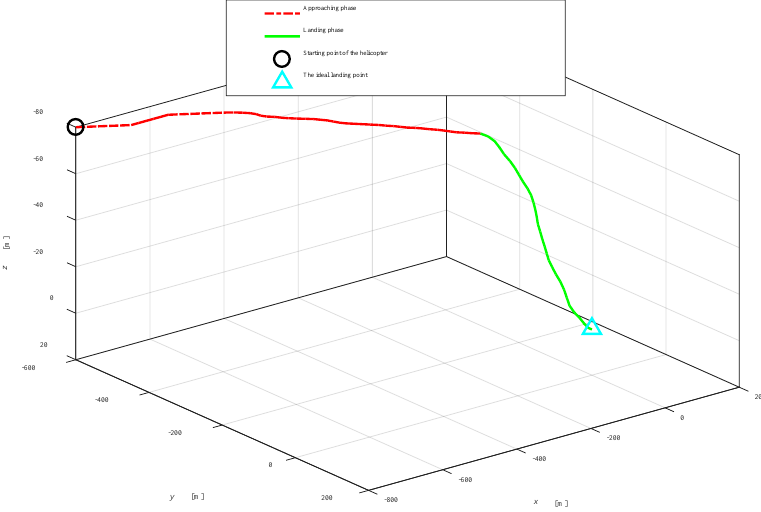
Figure 5. The landing path of the helicopter when the carrier is static.